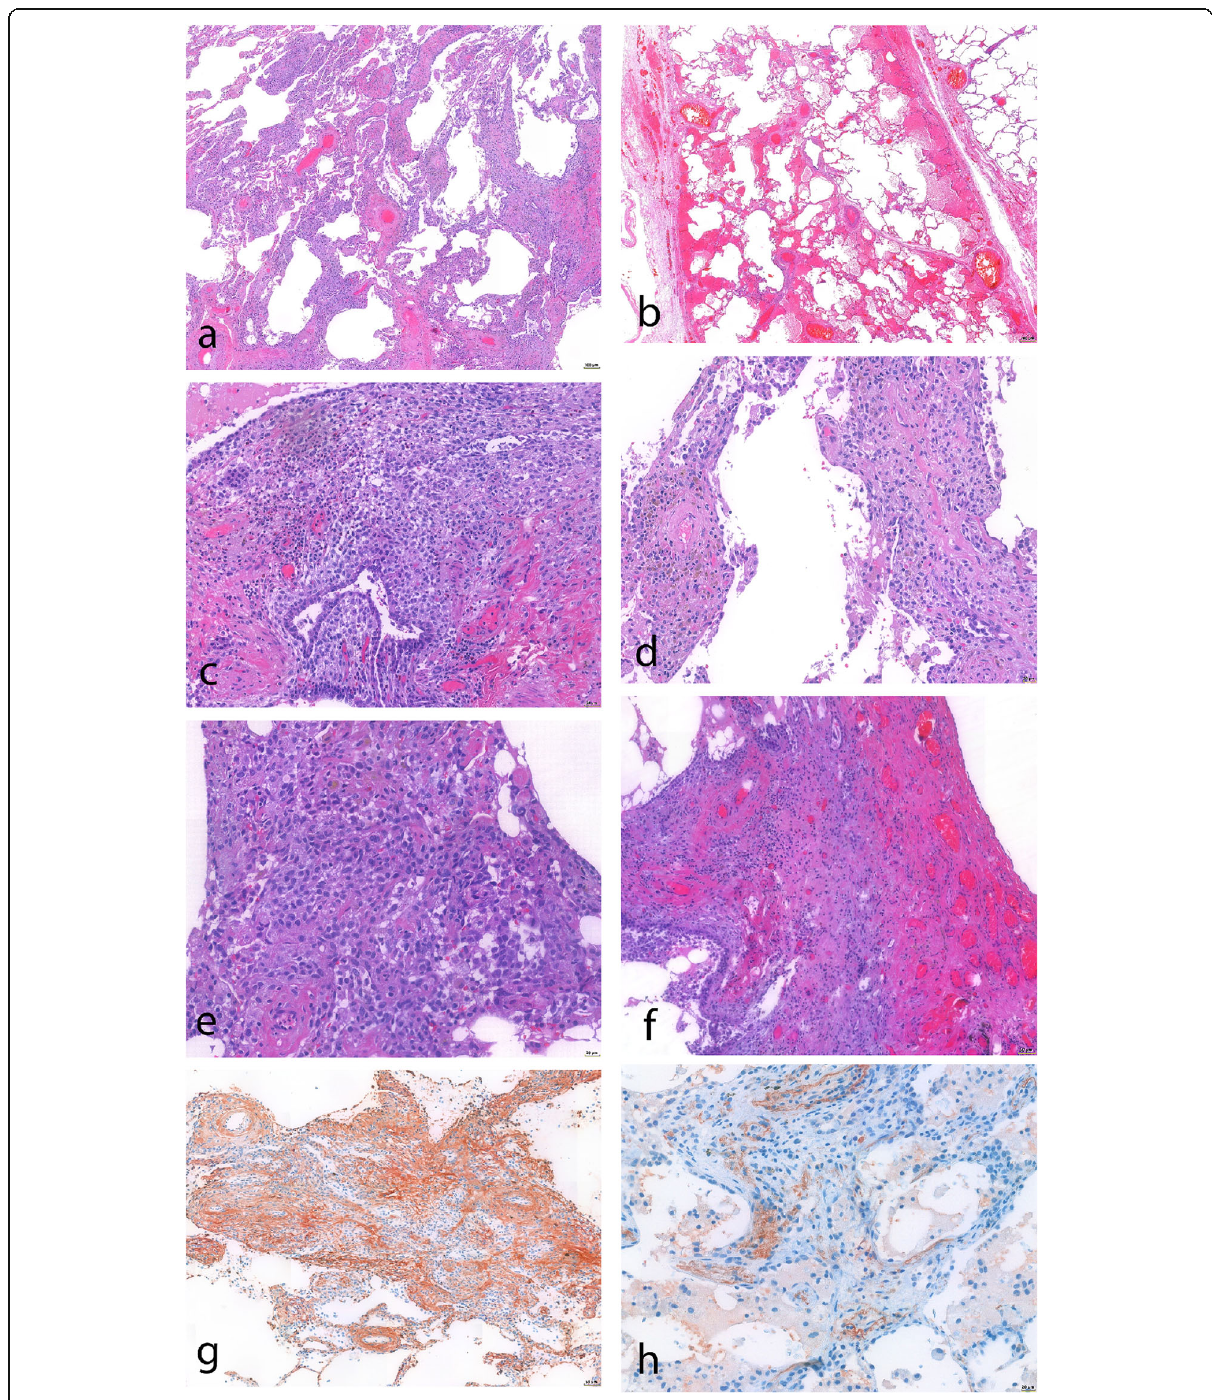
Fig. 13 Case of an autoimmune disease, probably SLE; a and b shows two different areas, one with LIP, the other with alveolar hemorrhage; in c - e ) there is a pattern which looks like LIP, but it could also be called NSIP; but as there is also BALT hyperplasia, which is uncommon in NSIP; in e and f ) there is fresh hemorrhage but also are siderin-laden macrophages; g and h ) shows deposition of immune complexes ( g ) and activation of the full complement cascade ( h ; C5 – 9 complex). H&E and immunohistochemistry for IGG and C5 – 9, bars 200, 100, 50, 20 μ m,